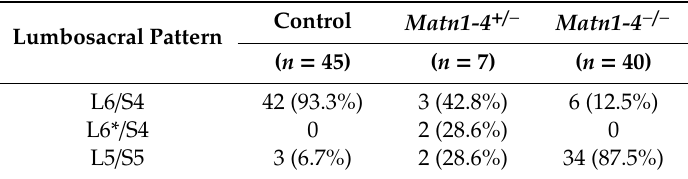
Table 1. Axial skeletal phenotypes in the respective